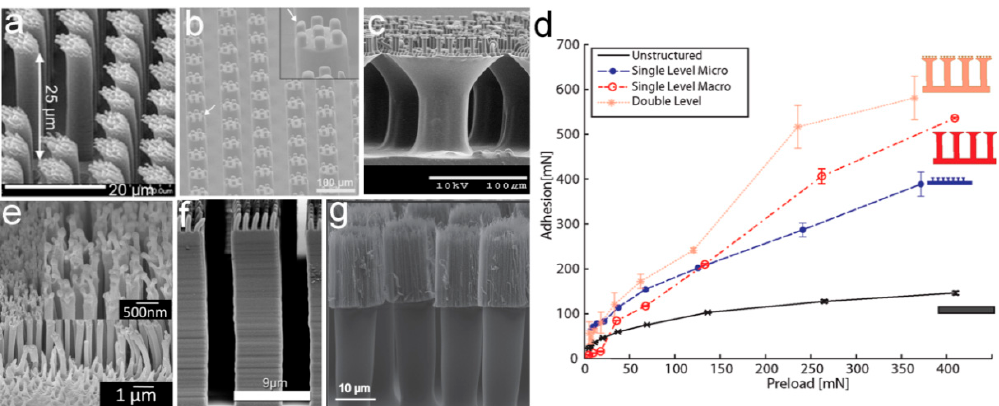
Figure 3. Two-level self-similar pillar arrays fabricated by various techniques. ( a ) Two-step molding with UV-curable polyurethane acrylate (PUA) resin. Reproduced with permission from [79]; ( b ) Polydimethylsiloxane (PDMS) replicated from a mold, prepared by two-step photolithography. Reproduced with permission from [80]; ( c ) Inking technique with polyurethane (PU); ( d ) Dependence of adhesion on preload for the unstructured, single primary structure (macro), single secondary structure (micro), and two-level structure. Reproduced with permission from [82]; ( e ) Capillary force-assisted molding from a multi-branched AAO template with grade Lexan polycarbonate (PC). Reprinted with permission from [86]. Copyright (2011) American Chemical Society; ( f ) Three-dimensional (3D) direct laser writing with acrylic-based negative photoresist (IP-G 780). Reproduced with permission from [89]; ( g ) Imprinting with carbon nanotube forests (CNTFs). Reproduced with permission from